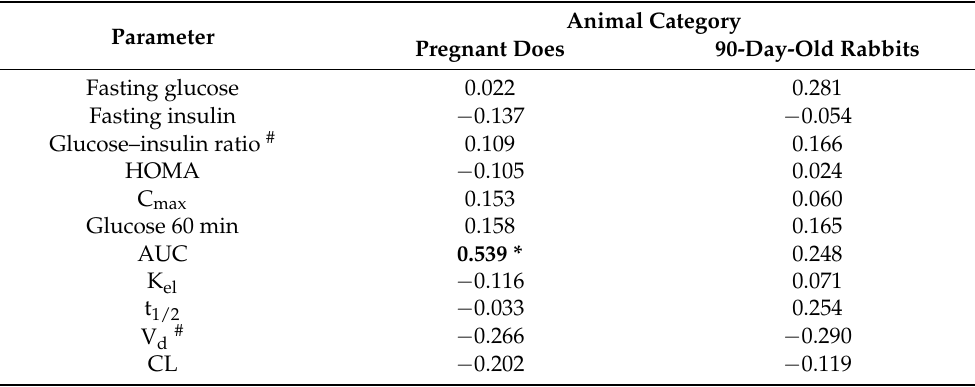
Table 4. Pearson coefficient showing correlations between BW and indices of insulin resistance in pregnant rabbit does and 90-day-old rabbits, regardless of group. Animal Category Parameter Pregnant Does 90-Day-Old Rabbits Fasting glucose 0.022 0.281 Fasting insulin −